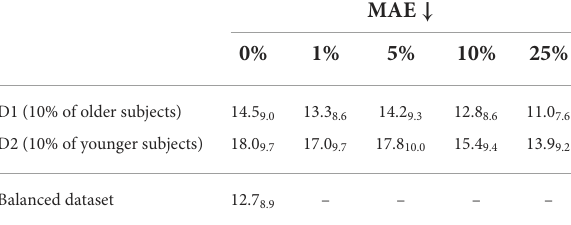
TABLE 4 Mean absolute error (MAE) of ResNet18 age regressors when trained with two imbalanced datasets and different proportions of added synthetic